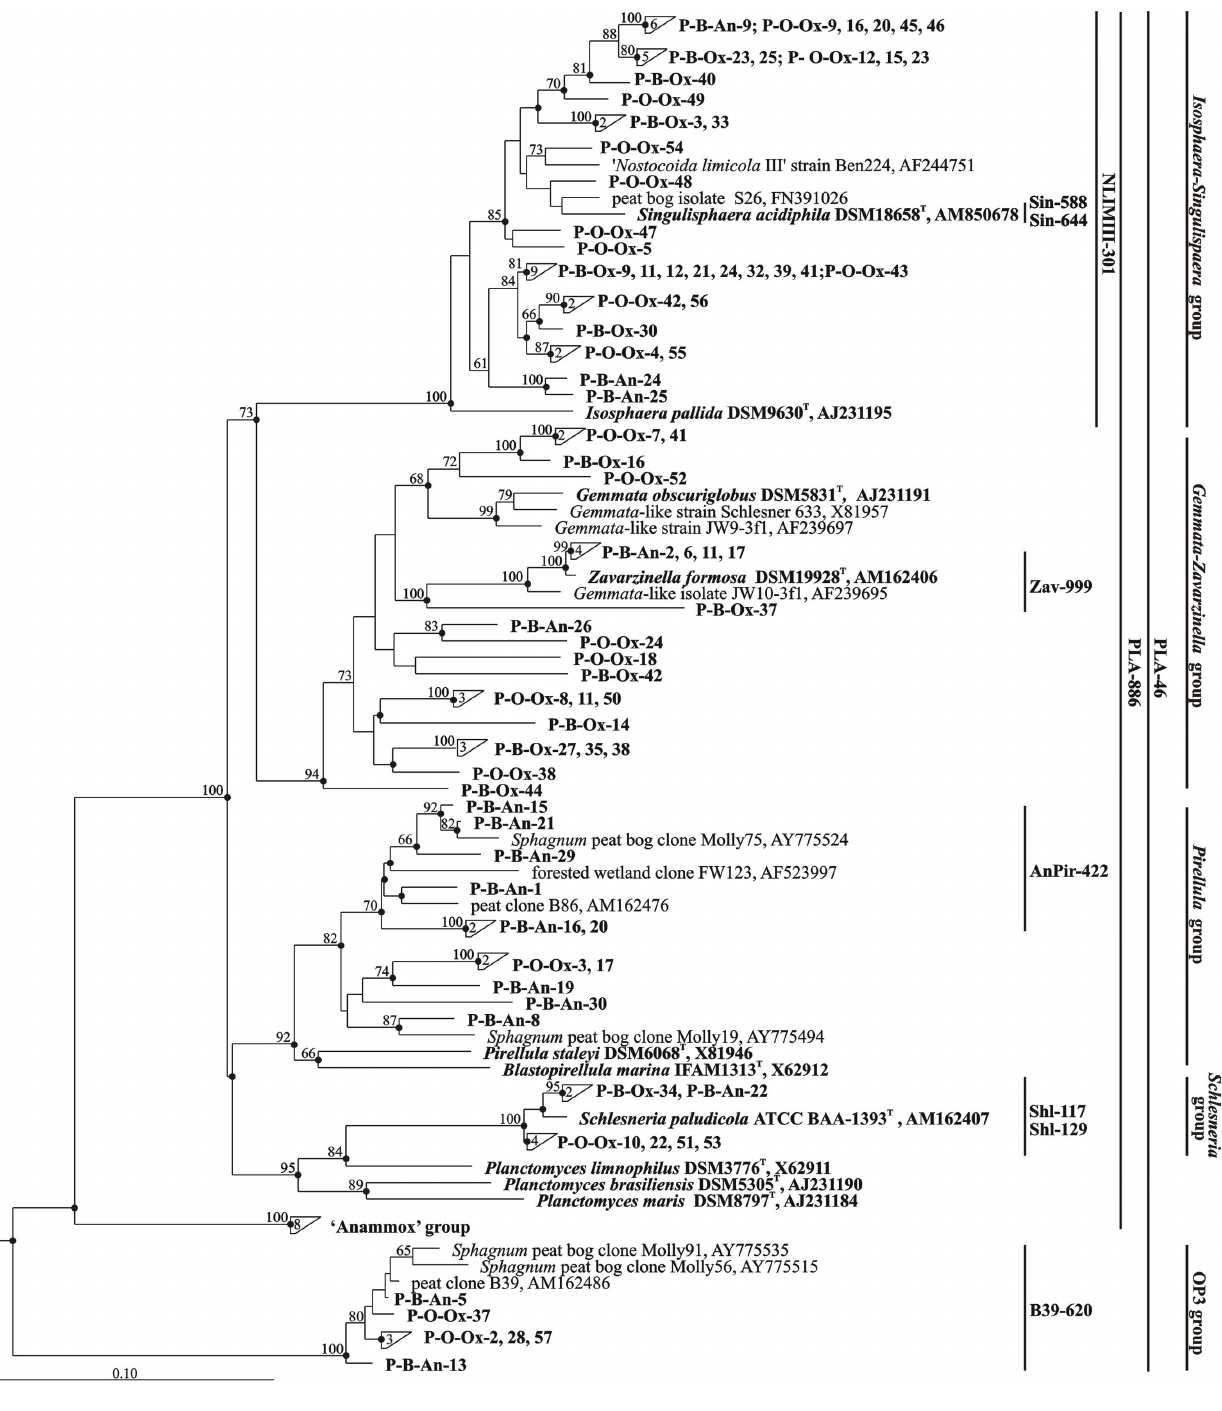
clusters.The brackets indicate the scope of each of the oligonucleotide probes applied in this study.The root was composed of ten 16S rRNA gene sequences from members of the Acidobacteria (accession numbers AM887757, AM887756, AM887758, AM887759, DQ660892, DQ528760, DQ528761, D26171, AM162405, and AY234728). Bootstrap values (1000 data resamplings) > 50% are shown. Bar, 0.10 substitutions per nucleotide